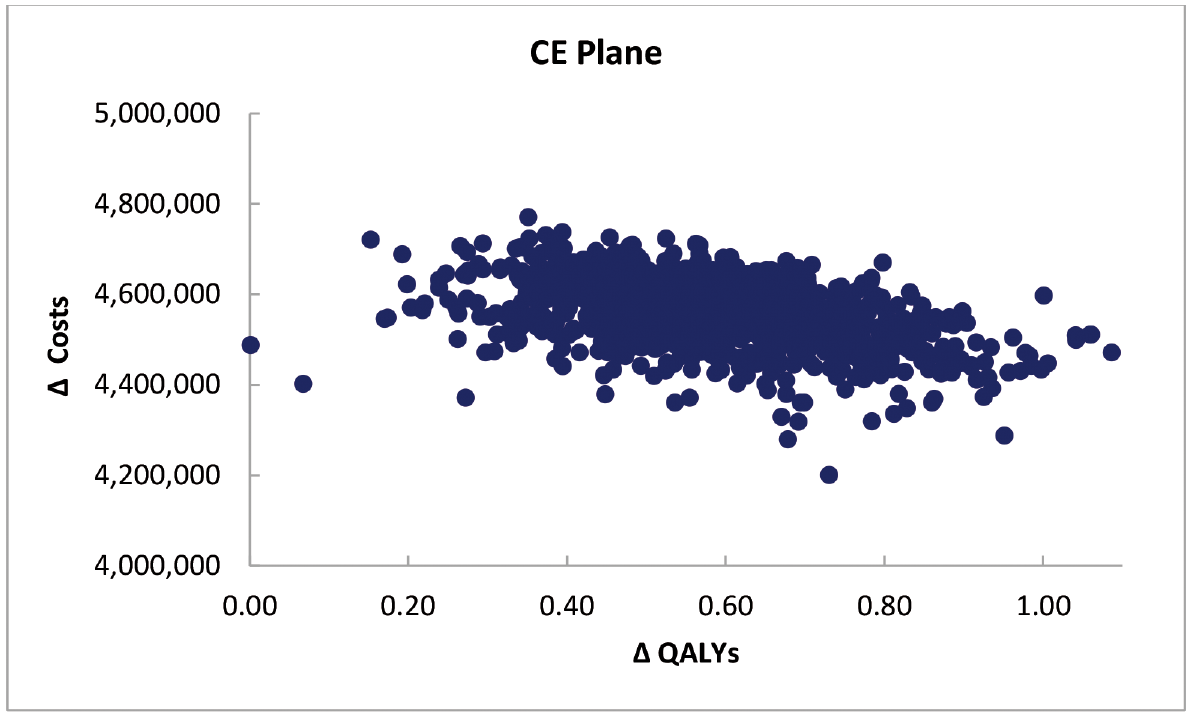
Figure 4. The Results of Probabilistic Sensitivity Analysis in Treatment-naive Patients